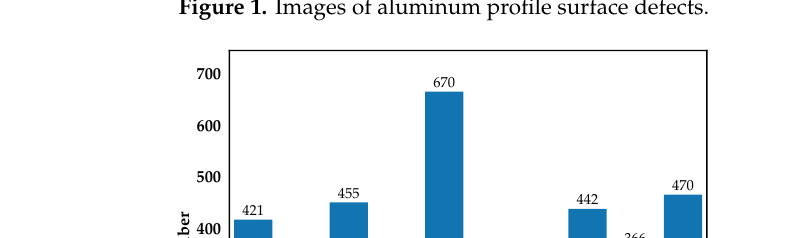
Figure 1. Images of aluminum profile surface defects.